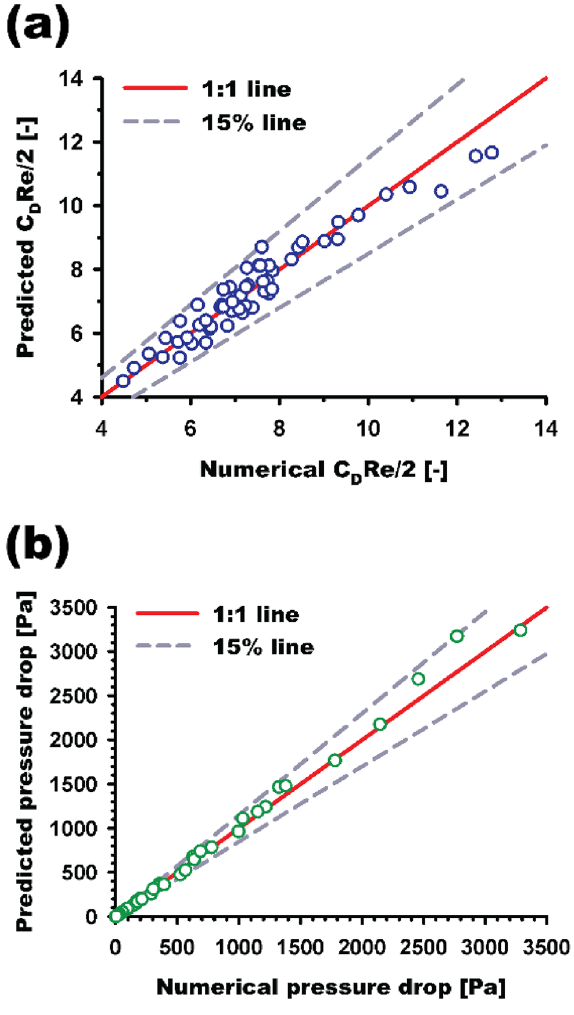
C D · Re and ( b ) pressure drop for all 2